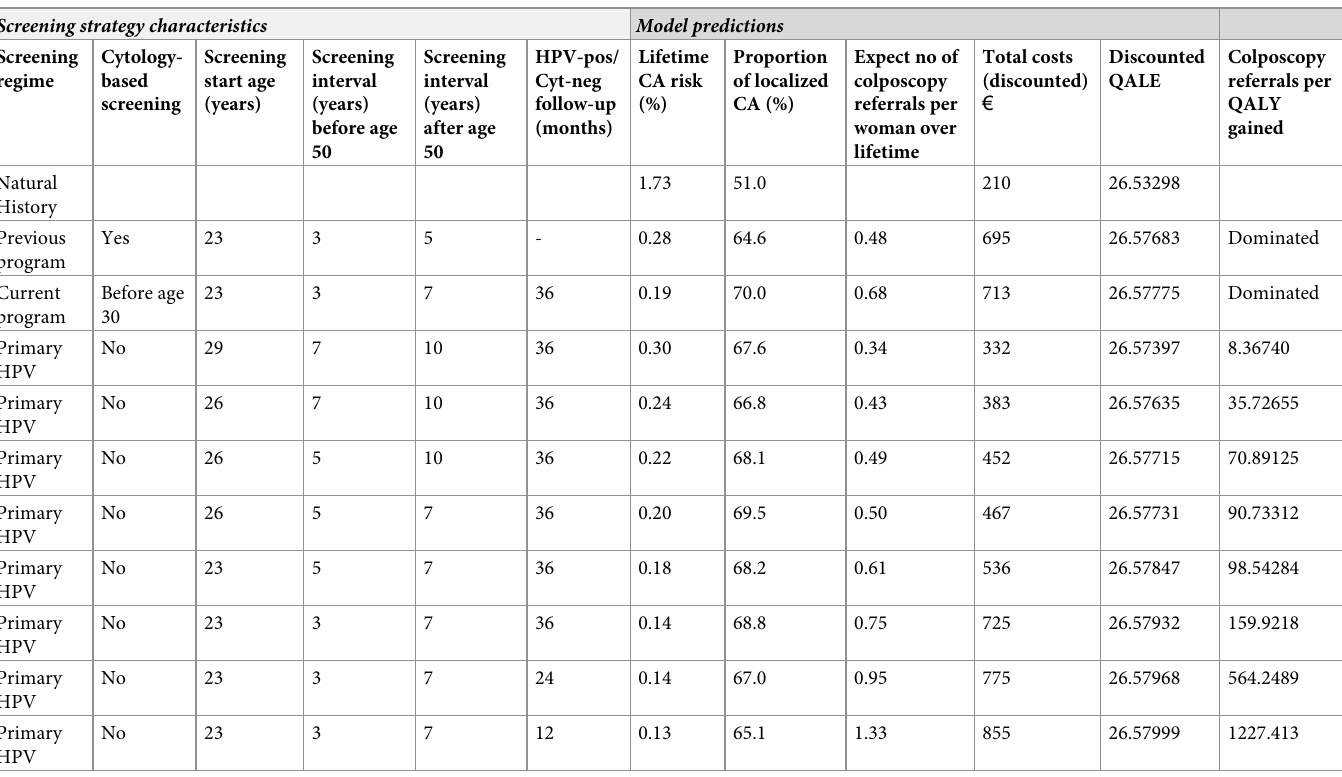
Table 3. Summary of the colposcopy-efficiency frontier under the baseline assumptions. Screening strategy